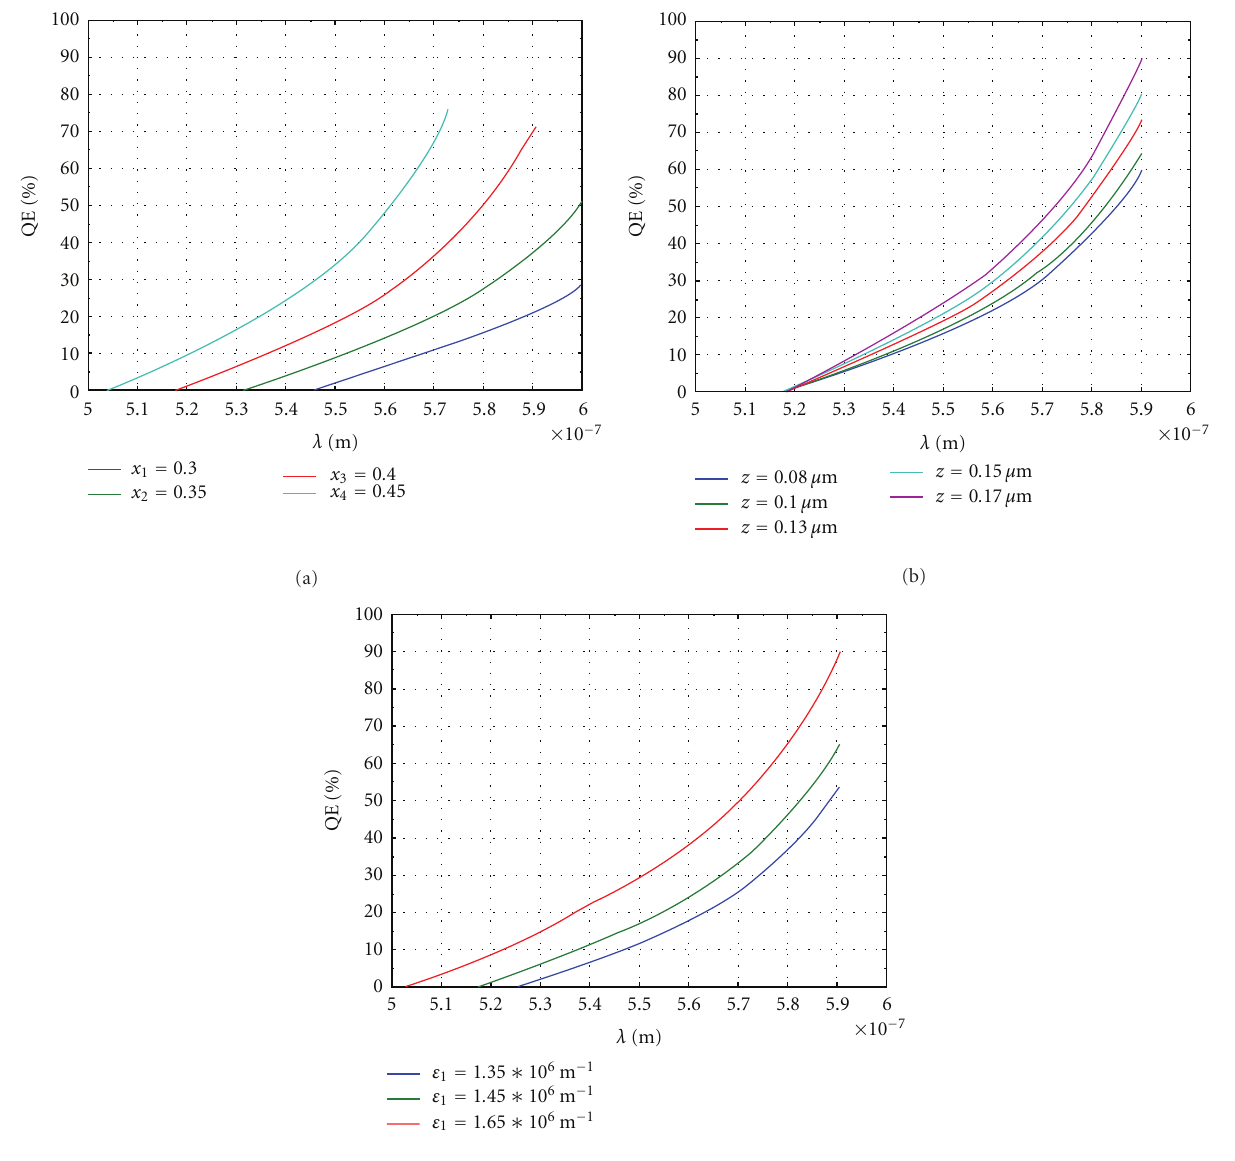
Figure 7: (a) Variation of the quantum e ffi ciency with the wavelength, for di ff erent fractions of Al. (b) Variation of the quantum e ffi ciency with the wavelength, for di ff erent solar cell thicknesses. (c) Variation of the quantum e ffi ciency with the wavelength, for di ff erent e ff ective